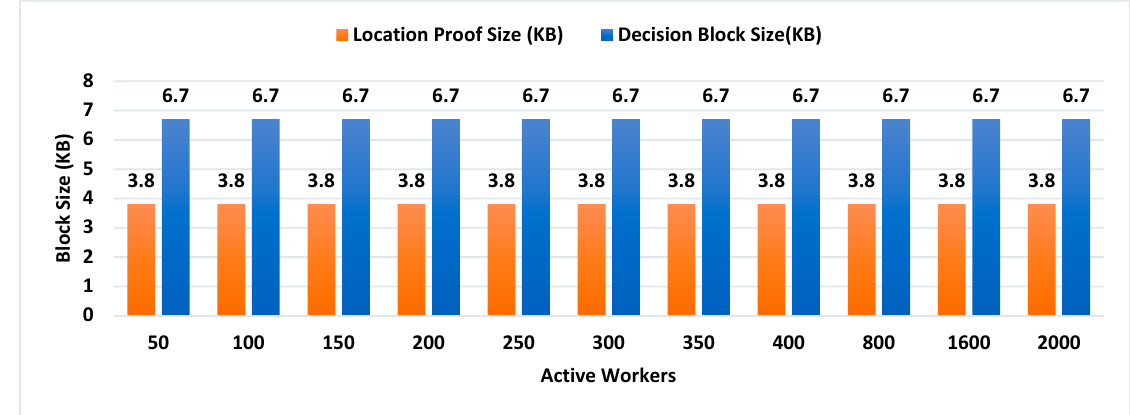
Figure 5. Impact of the number of active workers on the proof size and decision block size.